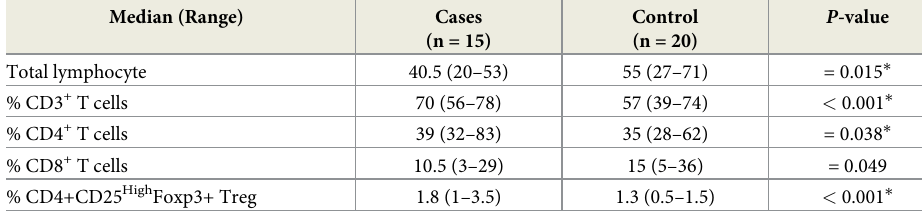
Table 3. Frequency of lymphocytes subsets and Treg cells among patients and healthy controls.